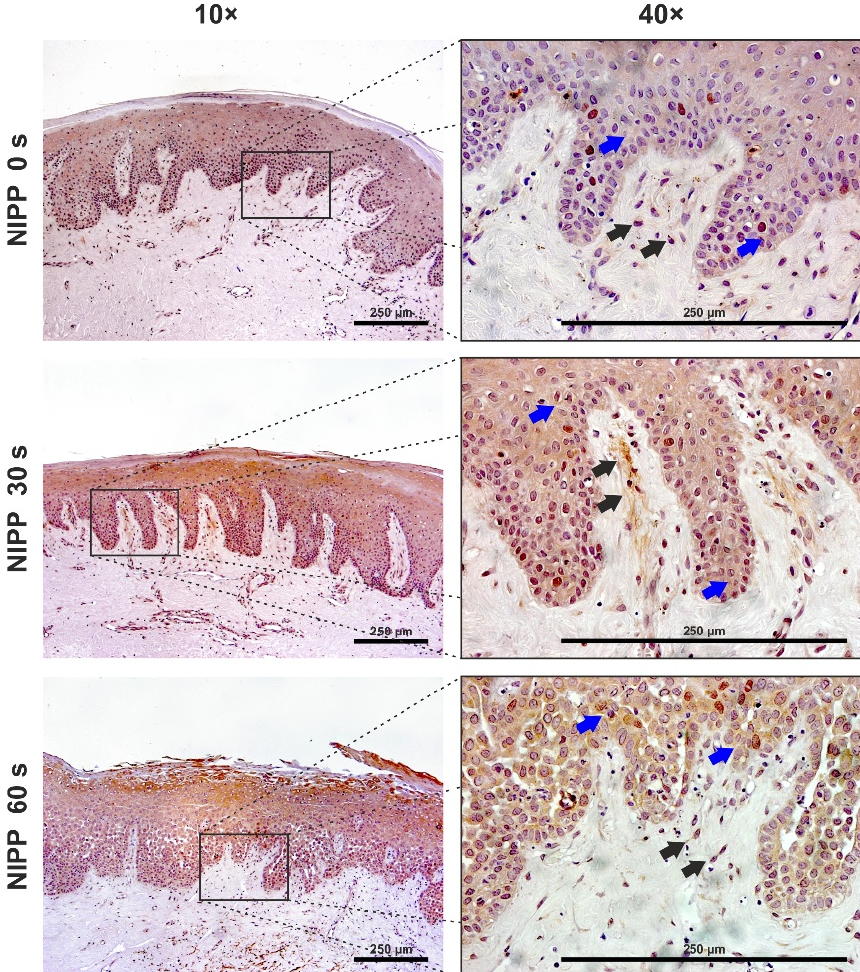
Figure 8. Influence of NIPP on gingival tissue biopsies at 24 h after NIPP treatment for 30 s and 60 s, as compared to the untreated group (NIPP 0 s). Ki67 staining, original magnification 10× and 40×. Blue arrows: positively stained HGK, black arrows: positively stained HGF. The scale bar represents 250 µm.